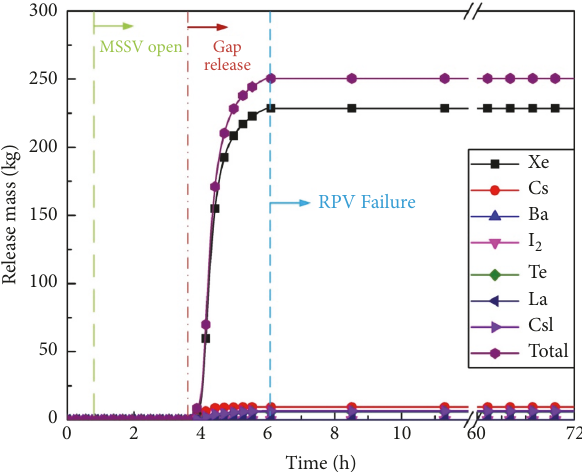
Figure 9: The release of mass of radionuclides to the environment in the base case.